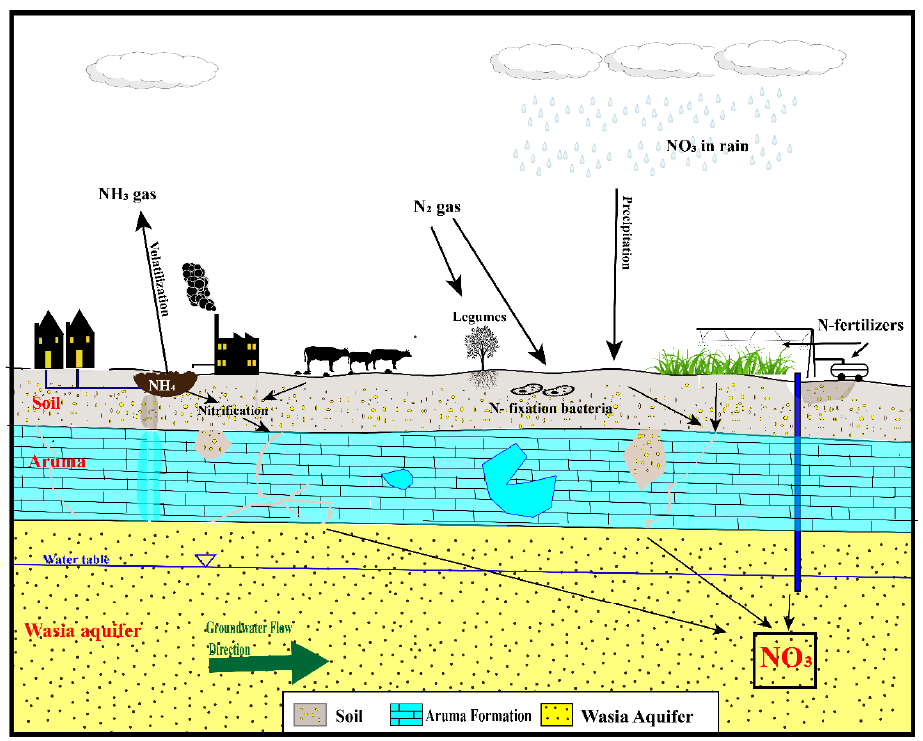
Figure 7. Schematic diagram of potential natural and anthropogenic sources for nitrate in the Al Kharj area.